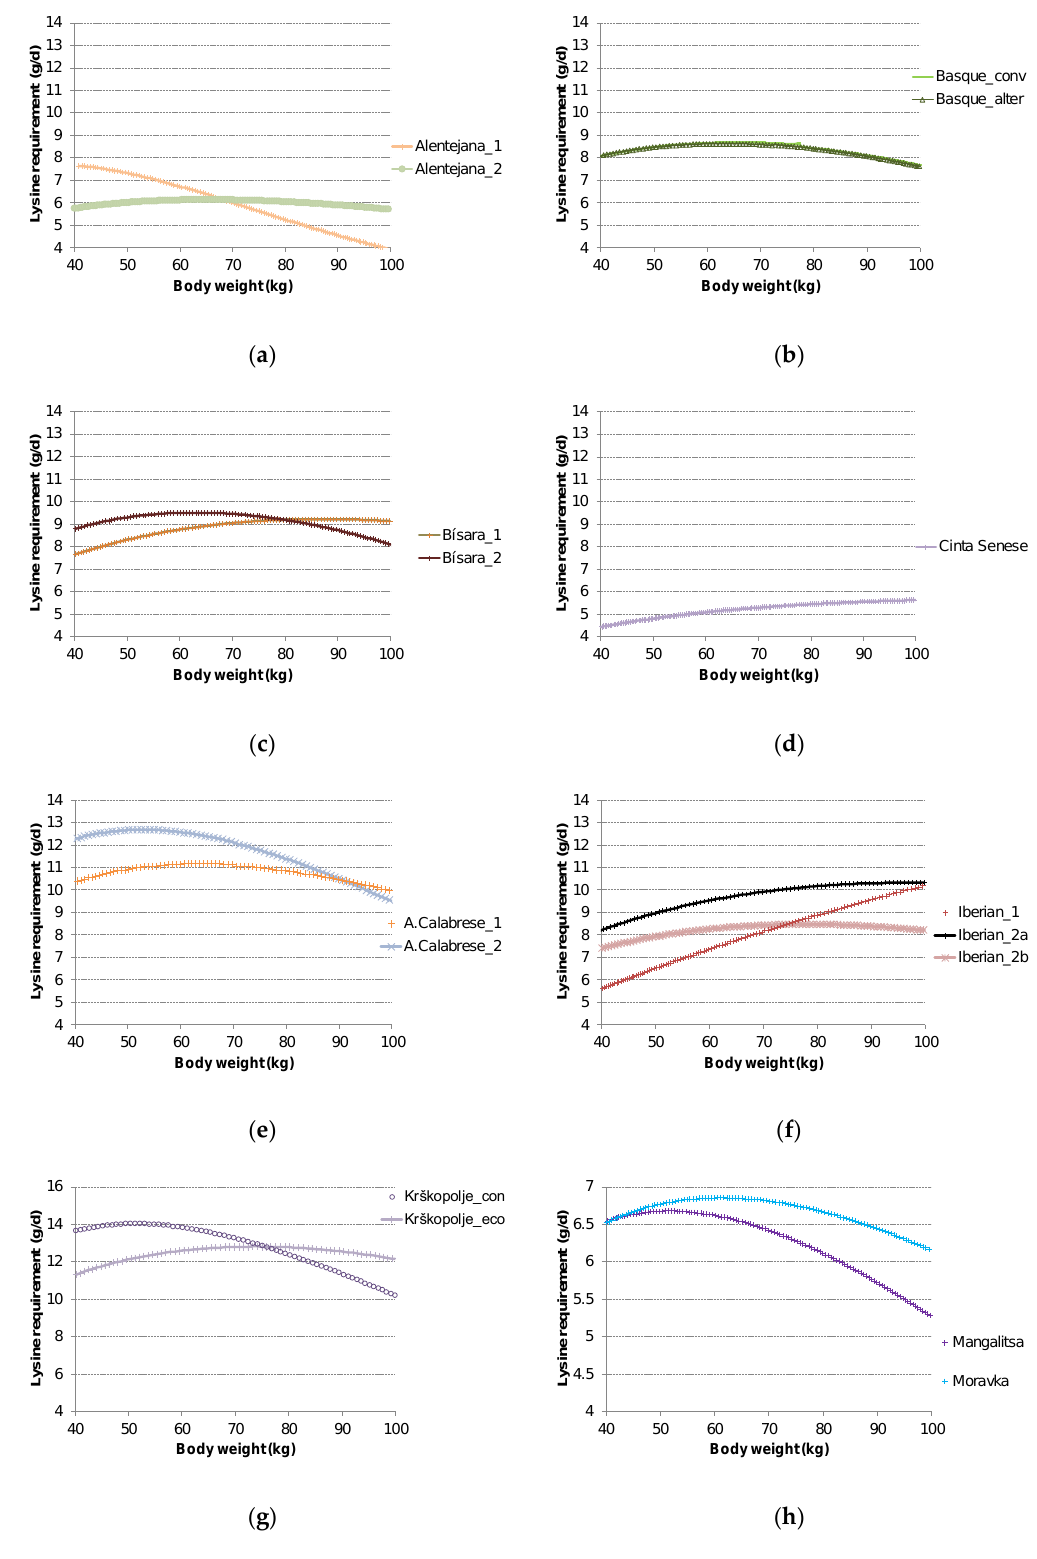
Figure 3. Standardized ileal digestible lysine requirement (g/d) for nine local breeds depending on body weight (kg) during the period 40 – 100 kg BW: ( a ) Alentejana; ( b ) Basque; ( c ) Bísara; ( d ) Cinta Senese; ( e ) Apulo Calabrese; ( f ) Iberian; ( g ) Krškopolje ; ( h ) Mangalitsa and Moravka.